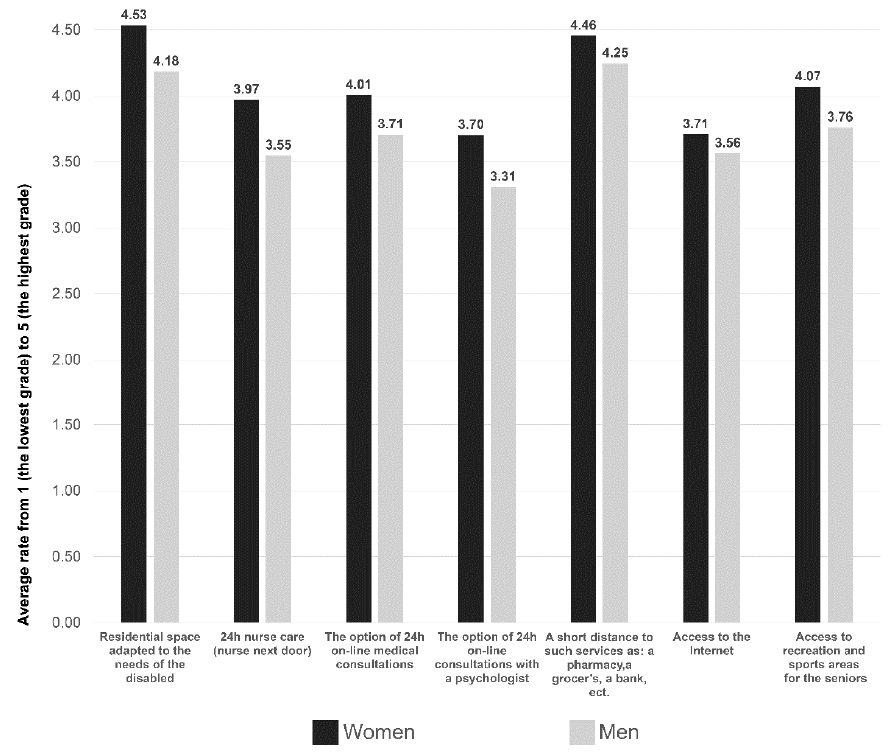
Figure 9. Willingness to change one’s own apartment for accommodation shared with children, de- pending on gender.